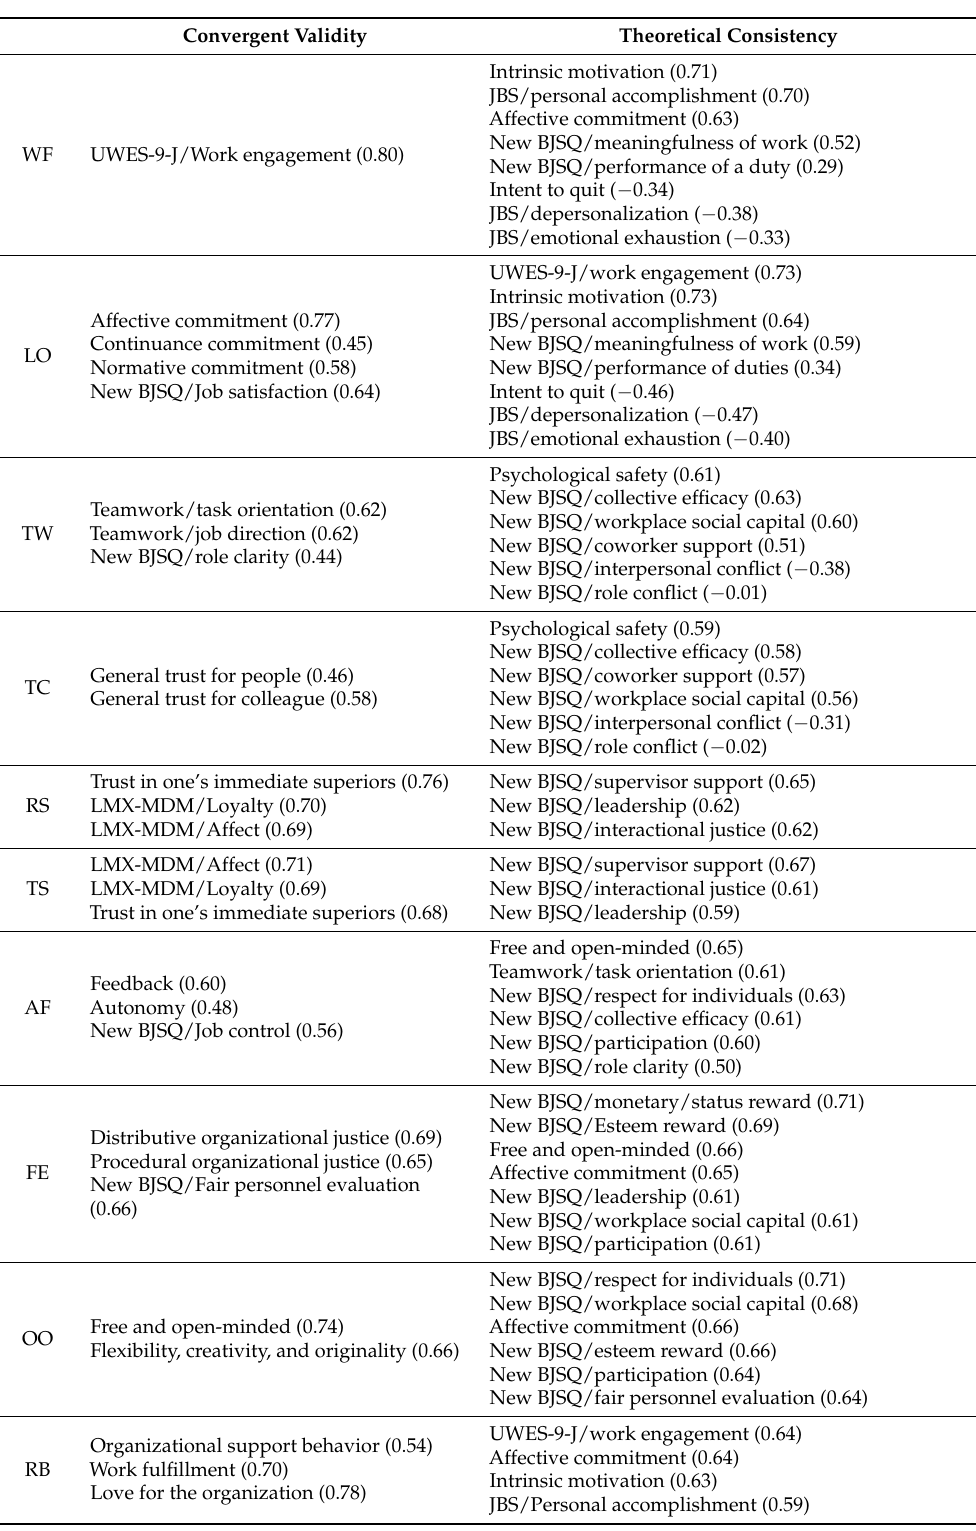
Table A4. Convergent validity of the Organizational Engagement Questionnaire. Values following the scale names are significant Pearson’s correlation coefficients with p < 0.001, except for role conflict ( n = 385 workers; males: 286, mean age 47.6 years; females: 99, mean age 41.1